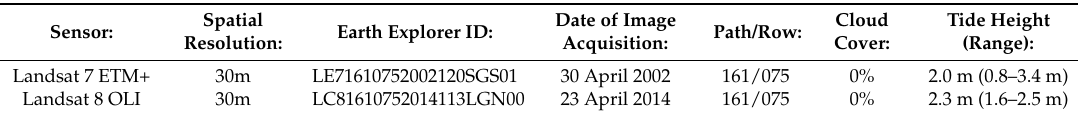
Table 1. Summary of the Landsat images used for land-cover stratification, mapping and mangrove dynamics analysis. Tide height (m) indicates average height above mean sea